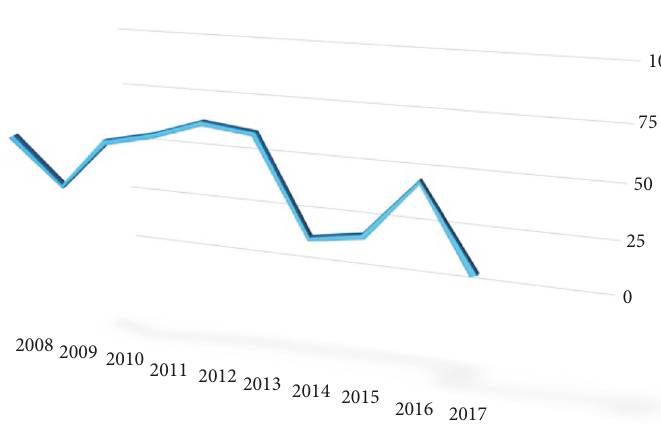
Figure 1: Distribution of the experimental animal research studies published in SCI-E emergency medicine journals according to years.